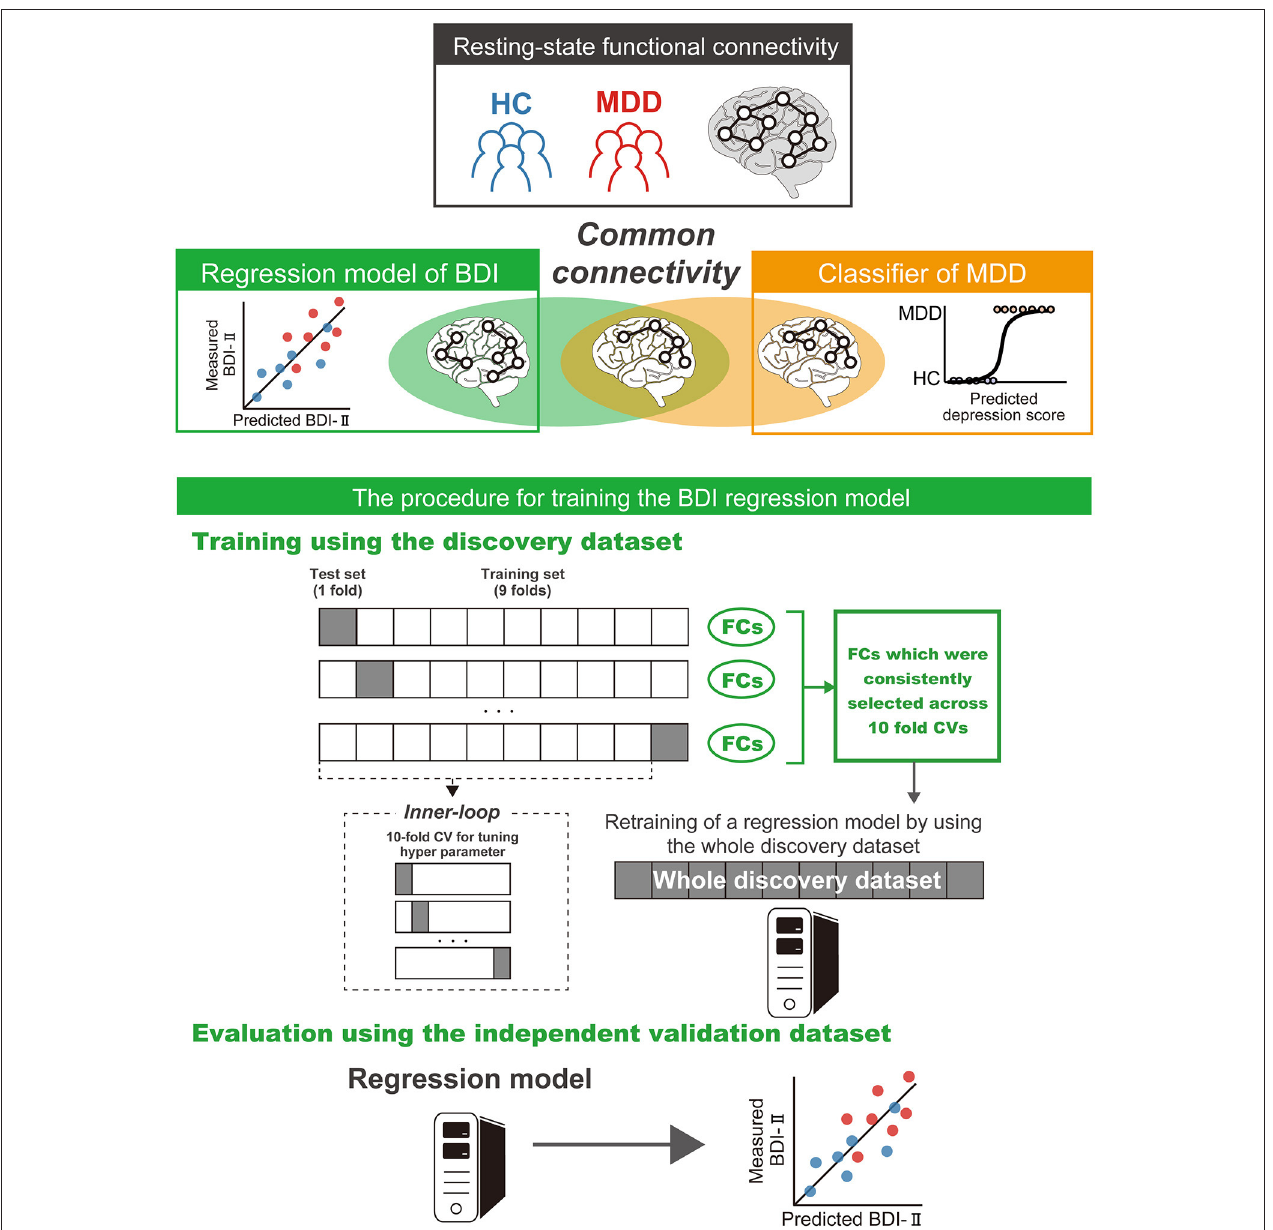
FIGURE 2 | Schematic representation of the procedure for training the brain network prediction model and evaluation of its predictive power. The BDI regression model was constructed using the union of FC values selected by the embedded method in the discovery dataset. Generalization performance was evaluated by applying the constructed regression model to the independent validation dataset. The machine learning regression model is represented by PC cartoons. BDI, Beck Depression Inventory-II; CV, cross validation; MDD, major depressive disorder; HC, healthy control; FC, functional